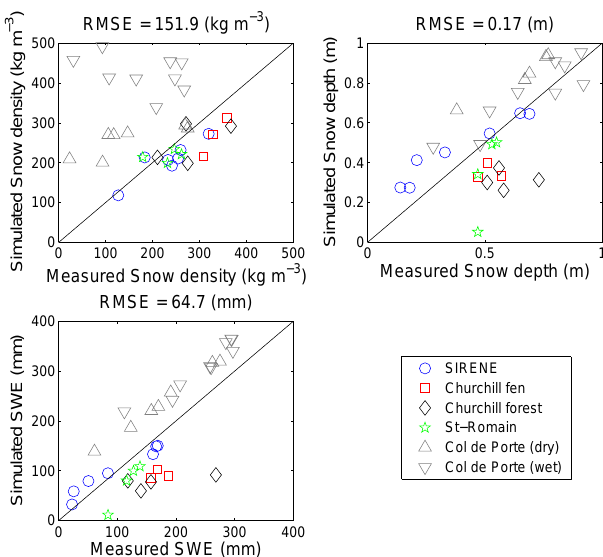
Fig. 3. Comparison of CLASS simulated snow properties with field measurements at different sites. Dry and wet sites at Col de Porte are separately indicated (see legend).